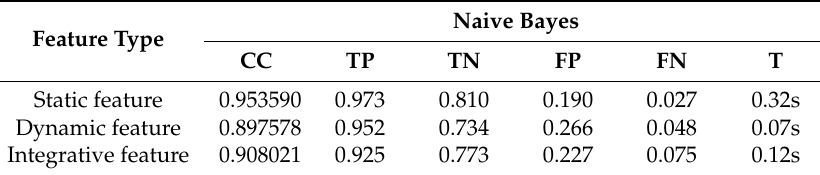
Table 3. The results of the naive Bayes algorithm.CC (Correctly Classified rate, CC), TP (True Positive